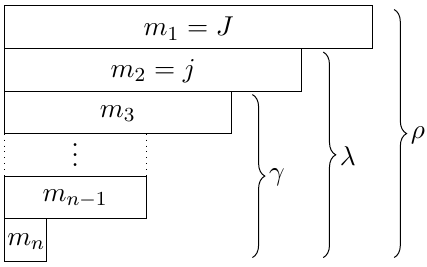
Figure 4 . A Young diagram for an irreducible representation ρ of SO( d − 1 , 1) . The rows have length m 1 , m 2 , . . . , m n . We often write m 1 = J (spin) and m 2 = j (transverse spin). If we remove the first row of the Young diagram for ρ , the remaining rows ( m 2 , . . . , m n ) make a Young